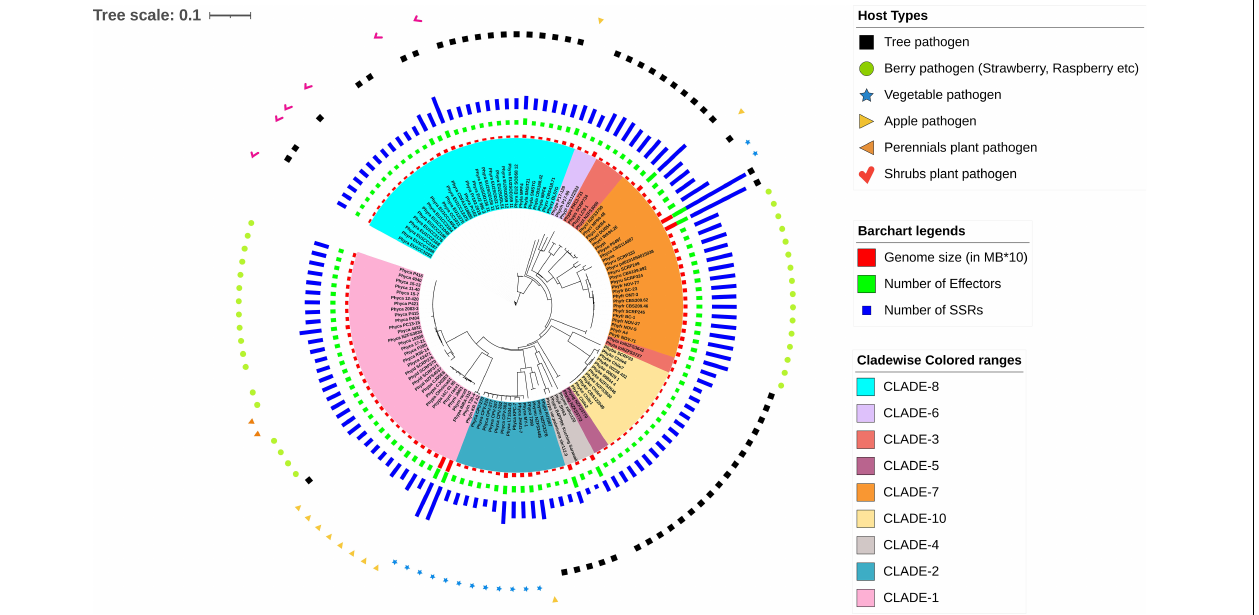
FIGURE 4 | A rooted phylogenetic tree showing evolutionary relationships and the connections between the 128 Phytophthora isolates. The tree is generated using NJ methods in the Mashtree software. The genomes are highlighted in different colors according to their clades as described by Yang et al. (2017) and are as follows: cyan, CLADE-8; light violet, CLADE-6; deep pink, CLADE-3; deep violet, CLADE-5; orange, CLADE-7; pale yellow, CLADE-10; gray, CLADE-4; blue, CLADE-2; and light pink, CLADE-1. Different genome features are represented in the form of bar charts such as red bar plot for genome size (in MB*10), green for number of effectors, and violet for number of SSRs. The host types for the Phytophthora pathogens are shown using different symbols over the bar charts such as black square for Tree pathogen, green circle for Berry pathogen (strawberry, raspberry, etc.); blue star for Vegetable pathogen; pale-yellow right-sided triangle for Apple pathogen; orange left-sided triangle for Perennials plant pathogen; and pink tick for Shrubs plant pathogen.